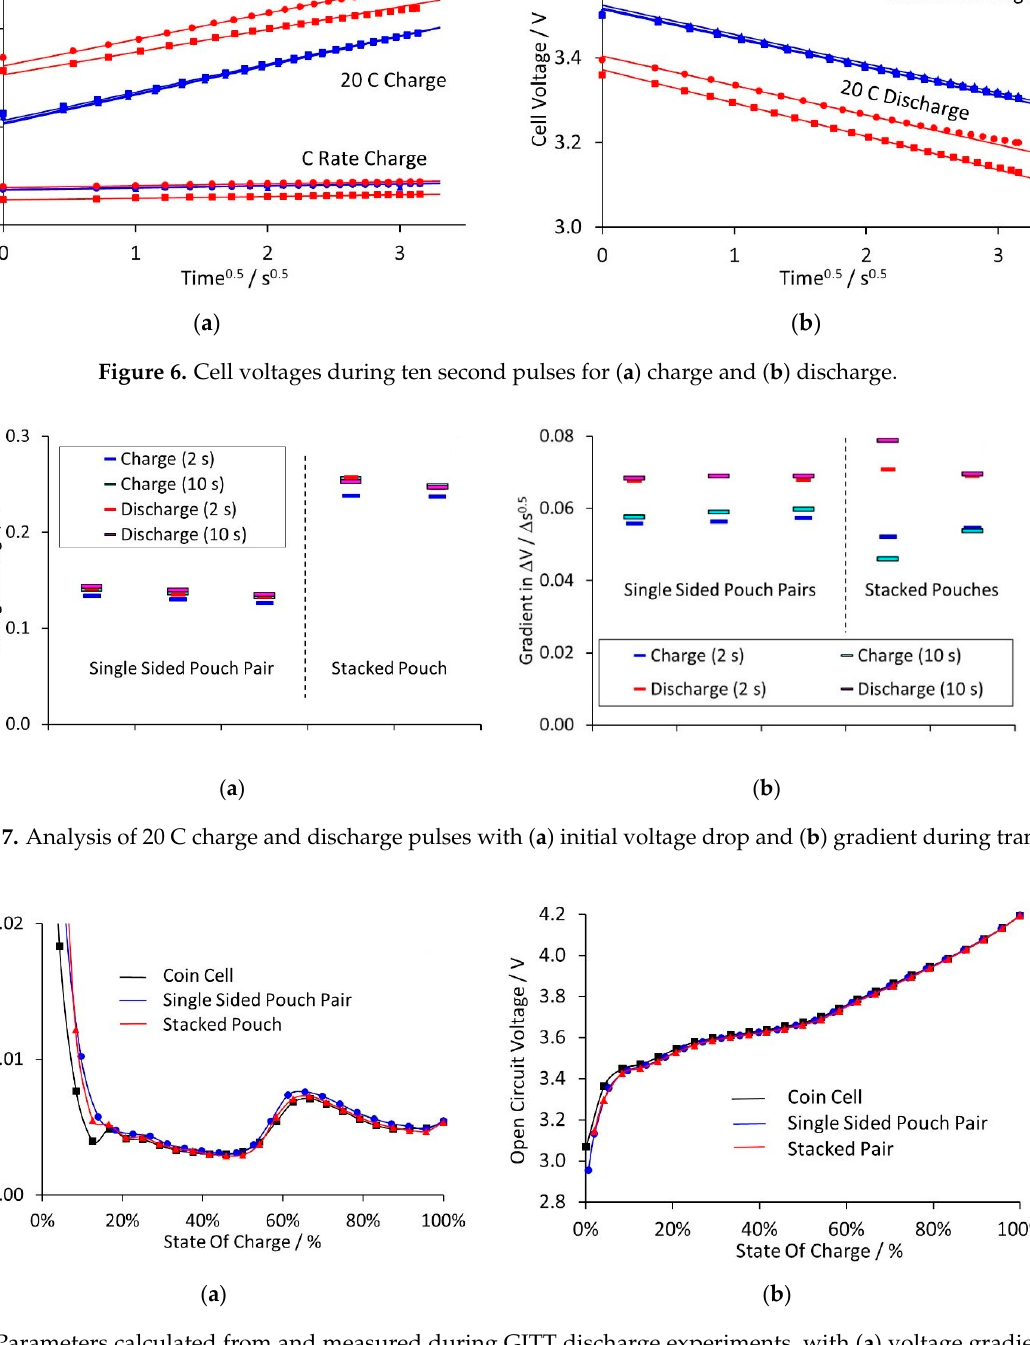
Figure 8. Parameters calculated from and measured during GITT discharge experiments, with ( a ) voltage gradient and ( b ) open circuit voltages.